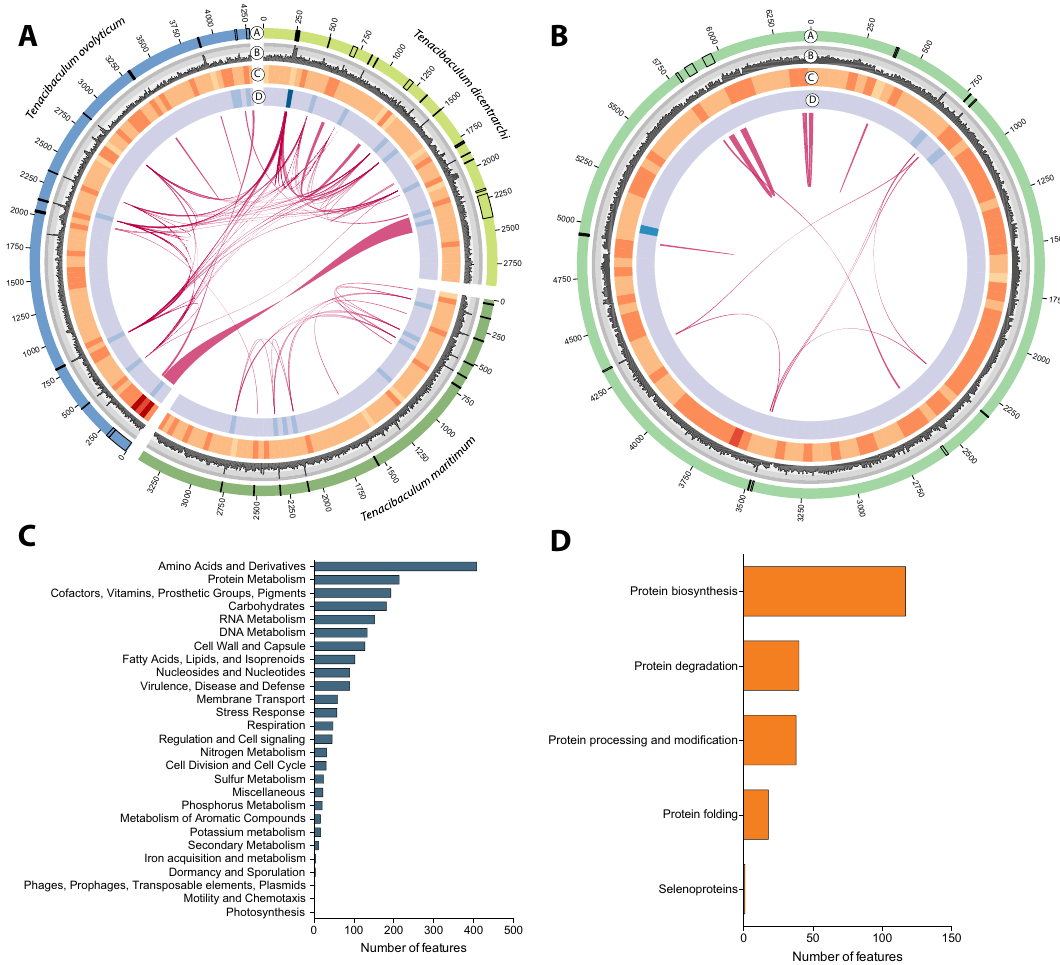
Figure 2. General overview of Tenacibaculum and Dokdonia sp. genomes. ( A ) Circos 65 plot representing different Tenacibaculum genomes including the genome size (a), GC content (b), CDS density (c), ncRNA density (d) and synteny blocks (ribons). ( B ) Genome characterization of Dokdonia sp. cluster. Circos 65 plot representing Dokdonia sp. genome including the genome size (a), GC content (b), CDS density (c), ncRNA density (d) and synteny blocks (ribons). ( C ) Functional annotation of the CDS characterize in Dokdonia sp. genome provided by RAST annotation. ( D ) Functional annotation of the CDS within amino acids metabolism found in Dokdonia sp.